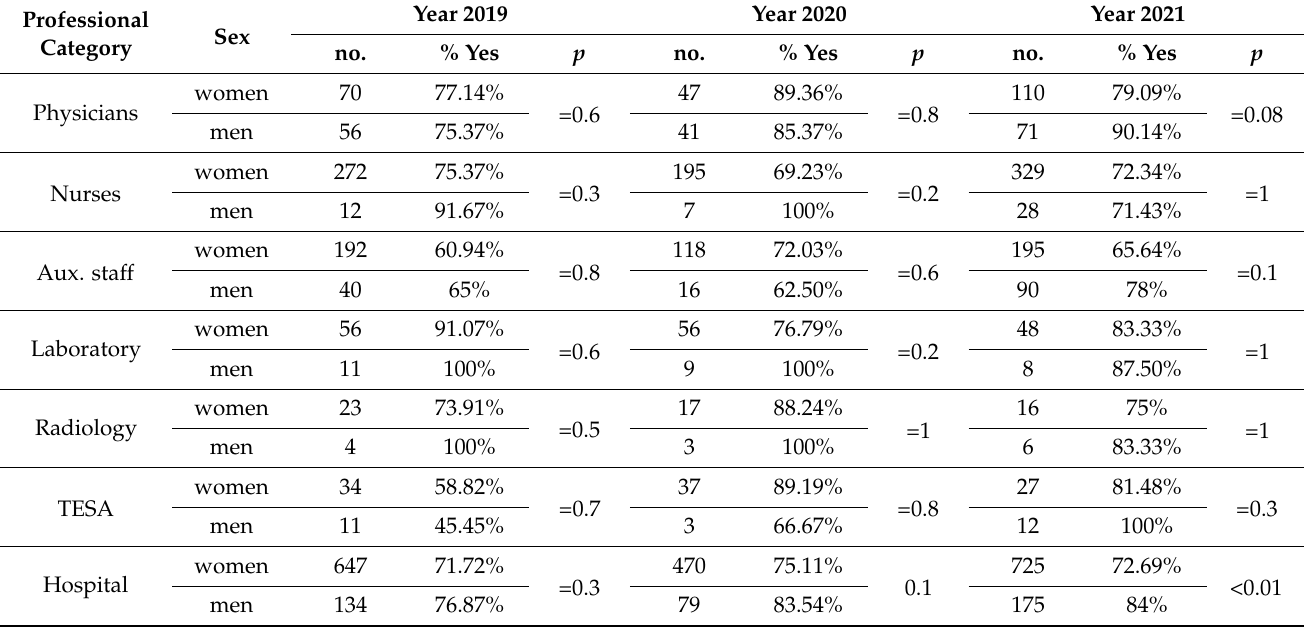
Table 3. The degree of staff motivation according to gender.